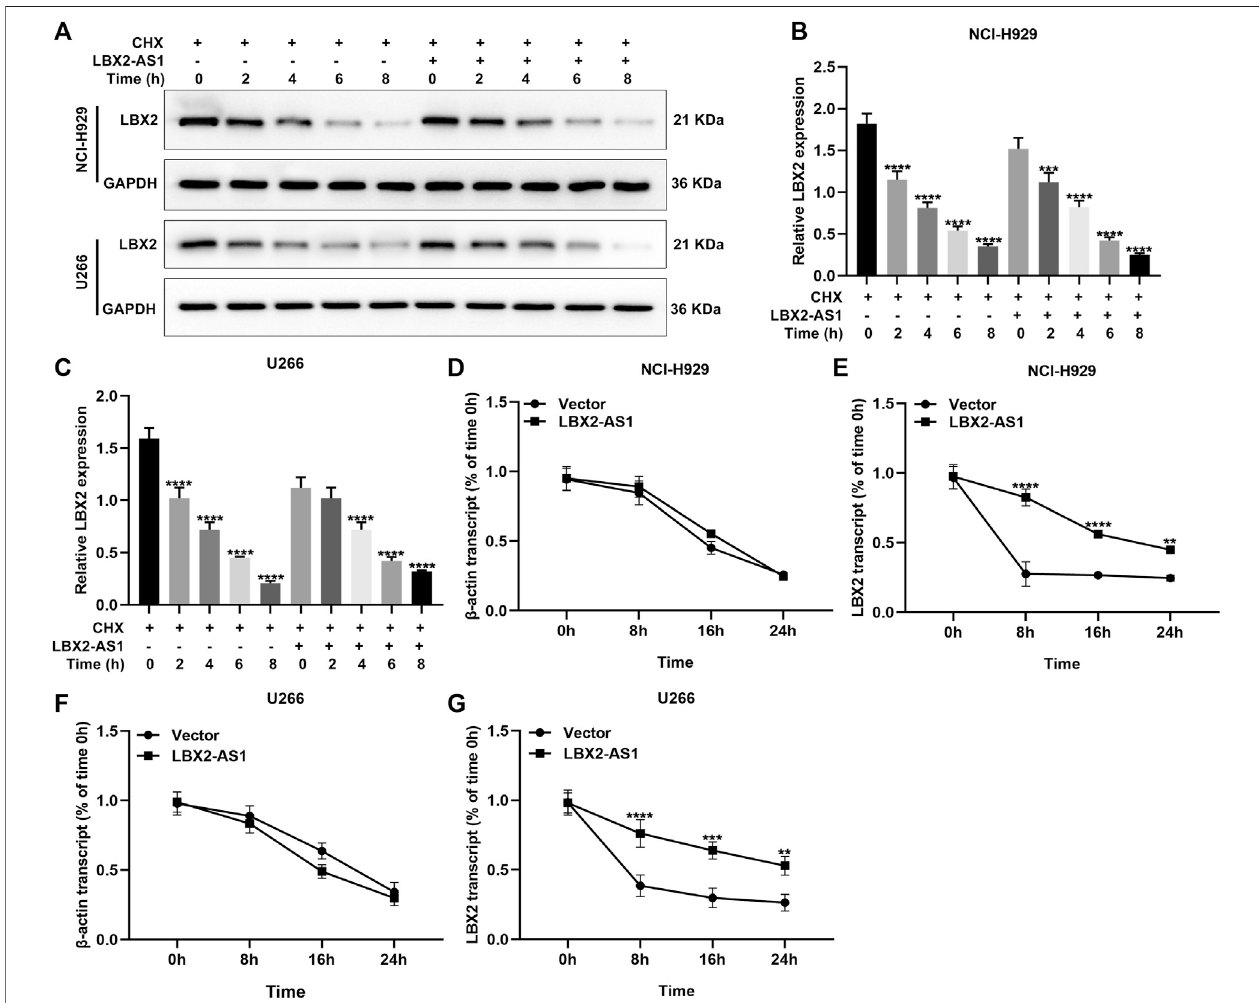
FIGURE 6 | LBX2-AS1 enhances the mRNA stability of LBX2 in MM cells. (A – C) Western blot for the expression of LBX2 protein in pcDNA3.1-LBX2-AS1- transfected NCI-H929 and U266 cells after treatment with CHX for 0, 2, 4, 6, and 8 h. (D – G) RT-qPCR for the expression of LBX2 mRNA in pcDNA3.1-LBX2-AS1- transfected NCI-H929 and U266 cells following treatment with actinomycin D for 0, 8, 16, and 24 h. ** p < 0.01; *** p < 0.001; **** p <